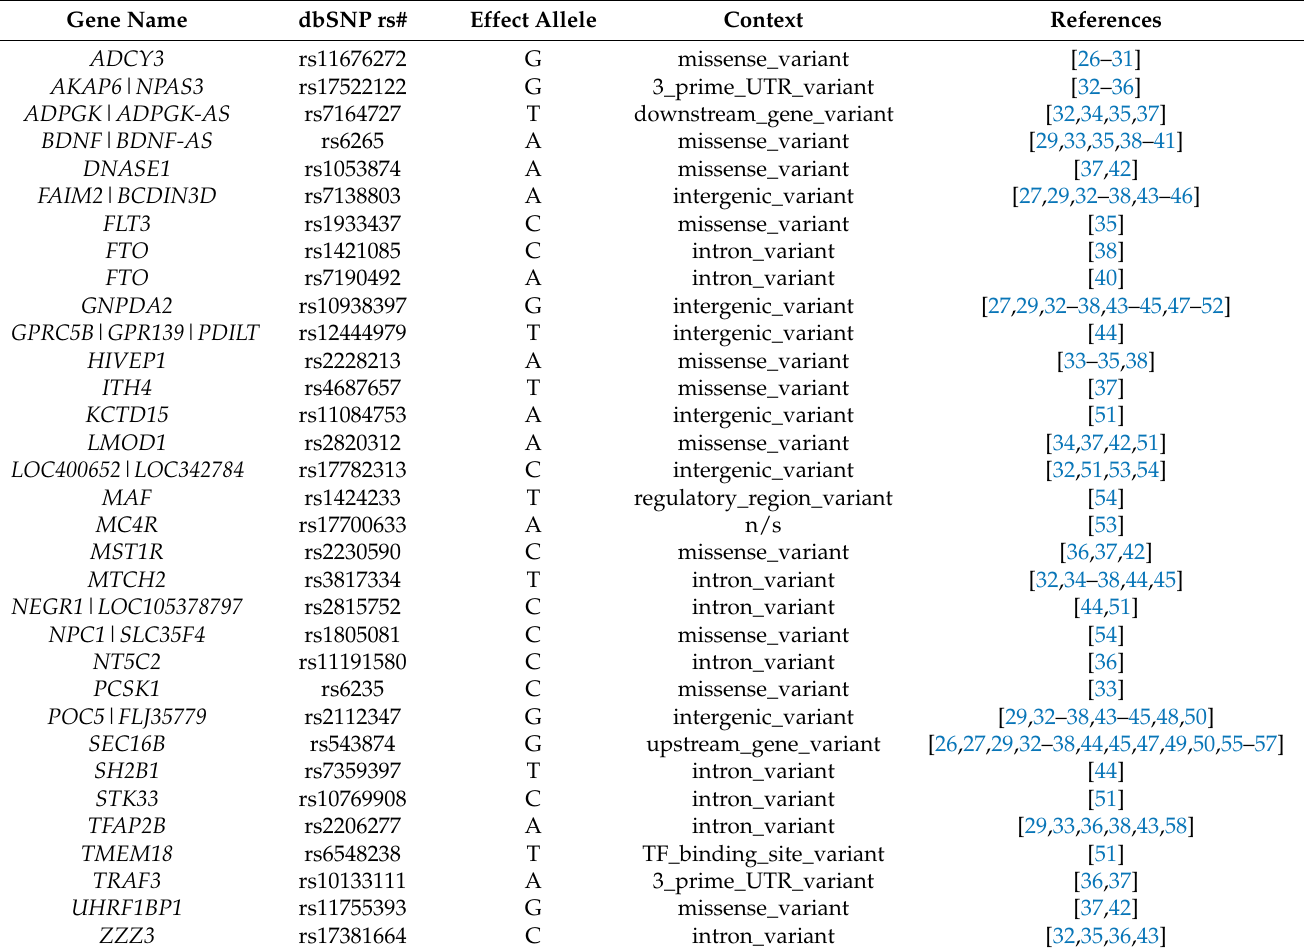
Table 2. Selected obesity-related